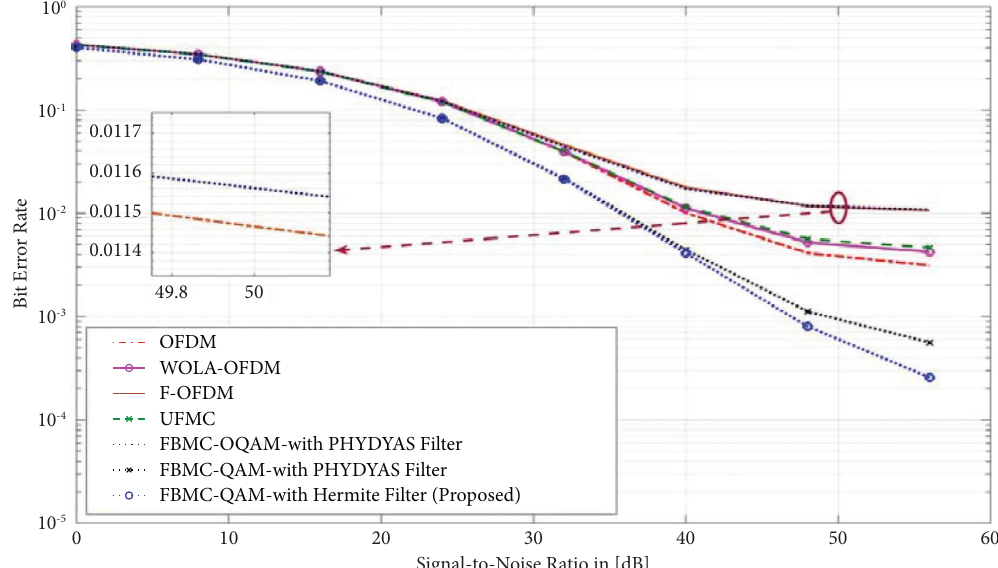
Figure 11: Bit error rate performance of diferent multicarrier modulation techniques for vehicular A channel model at 1024